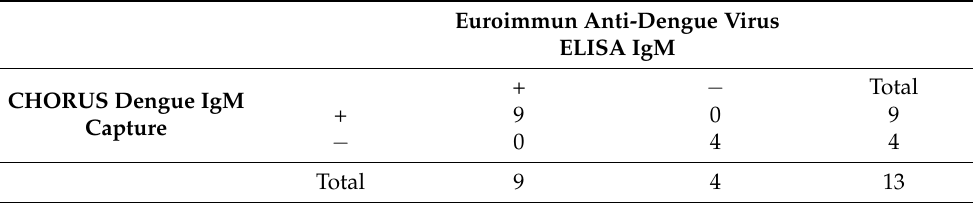
Table 6. Analysis of discordant samples with Euroimmun anti-Dengue Elisa